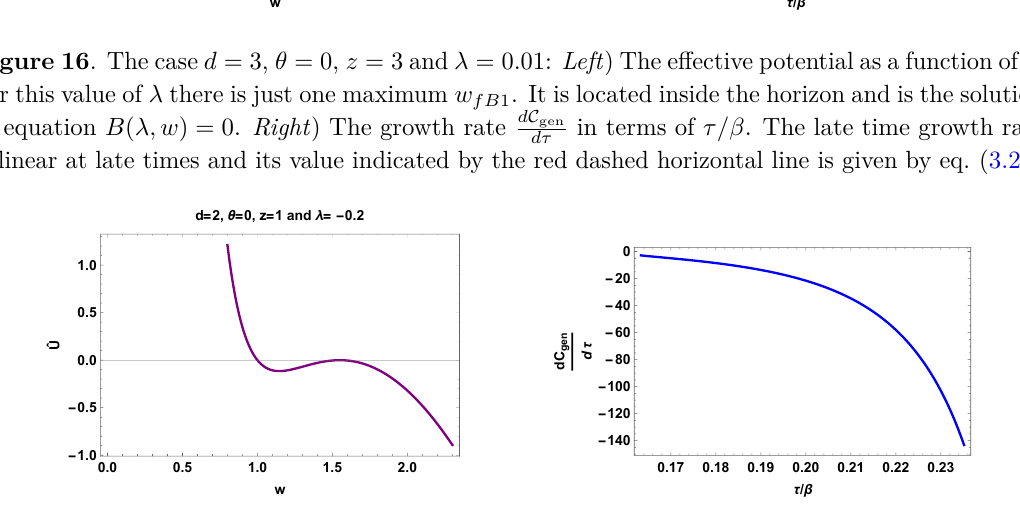
which is located inside the horizon. Right ) fA 1